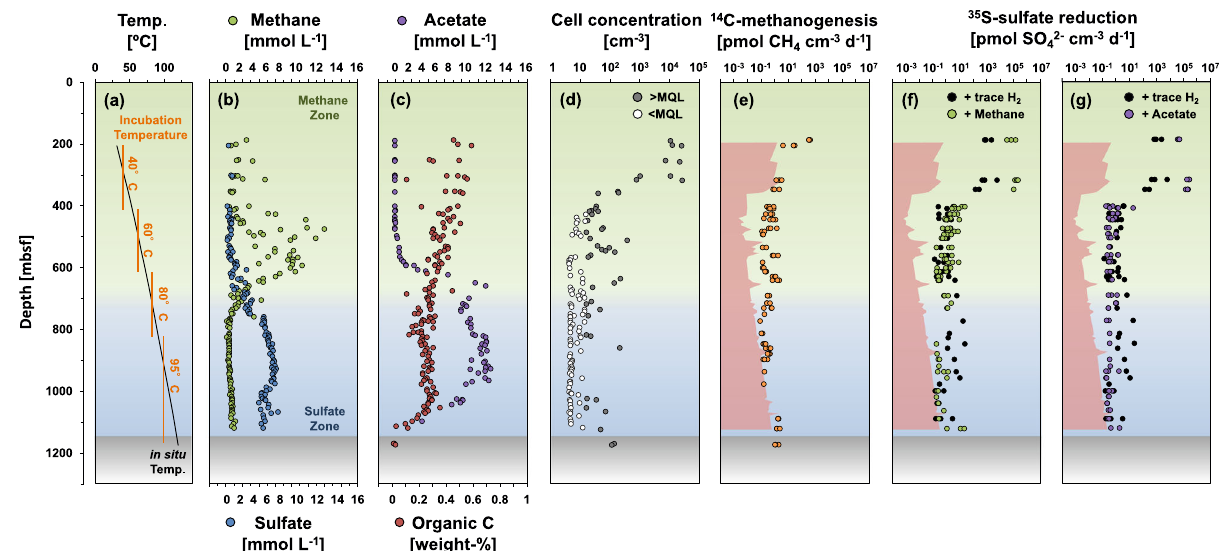
Fig. 1 Temperature, biogeochemistry, cell counts, and anaerobic microbial processes in IODP Site C0023 sediment. a Temperature of sediment and incubation experiments, b dissolved methane and sulfate, c dissolved acetate and bulk sediment organic carbon, d concentration of microbial cells fl uorescently stained with SYBR green, and e – g potential rates of methanogenesis from DIC (0.68 mmol L − 1 in medium) with trace H added and sulfate reduction from sulfate (5 mmol L − 1 in medium) with either trace H 2 (130 nmol L − 1 ), acetate (5 mmolL − 1 ), or methane (100 vol% CH 4 in the headspace) added. Note that sulfate reduction + trace H 2 is presented both in panel ( f ) and ( g ) for better comparison. For more details on the experimental setup, please refer to the methods. The minimum quanti fi cation limit (MQL) for cell counts was 16 cells cm − 3 . Data for methanogenesis and sulfate reduction is only shown for rates >MBQL (0.09 pmol CH 4 cm − 3 d − 1 and 0.13 pmol SO 4 2 − cm − 3 d − 1 ). Red shaded areas in ( e – g ) indicate the calculated rates necessary to repair thermal damage (Fig. S3). Data presented in panel a – e were discussed in a different context by Heuer et al. 12 . Source data for data in panel e – g are provided as a Source Data fi